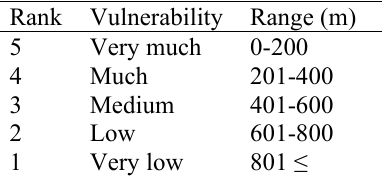
Table 9. Vulnerability and its ranking based on